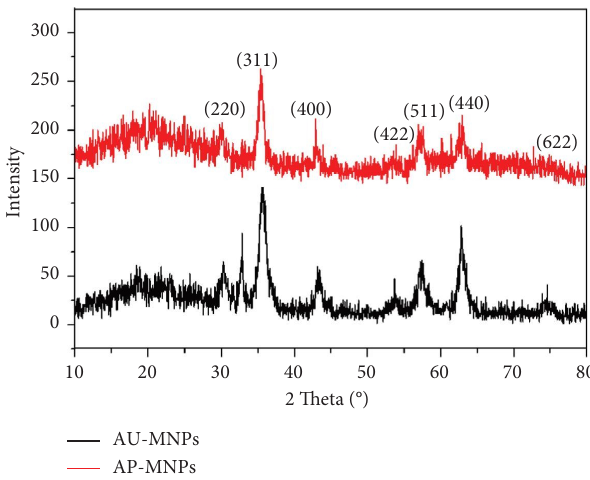
Figure 3: XRD of MNPs, AU-MNPs, and AP-MNPs.